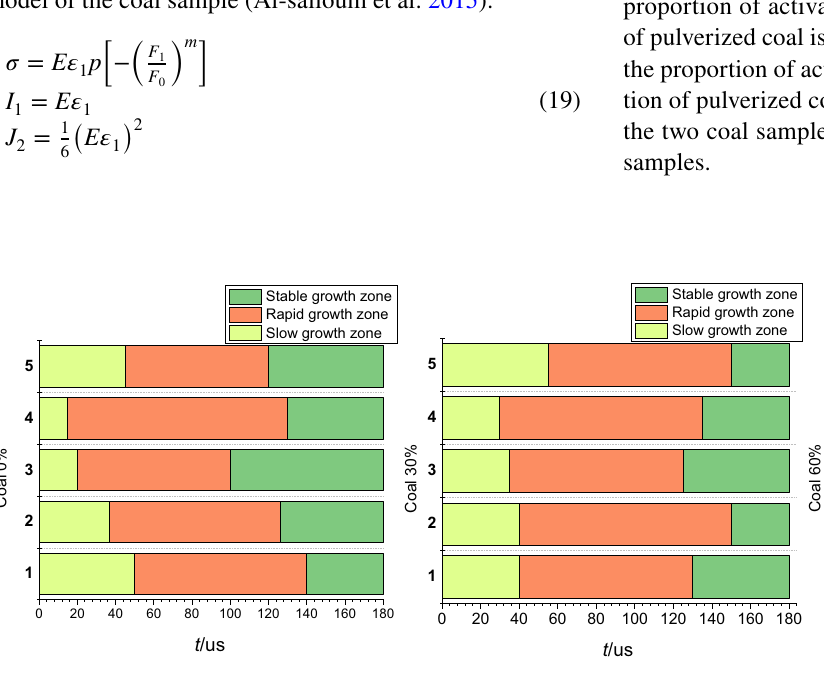
Fig. 5 Effect of moisture content of coal samples on transformation of stress